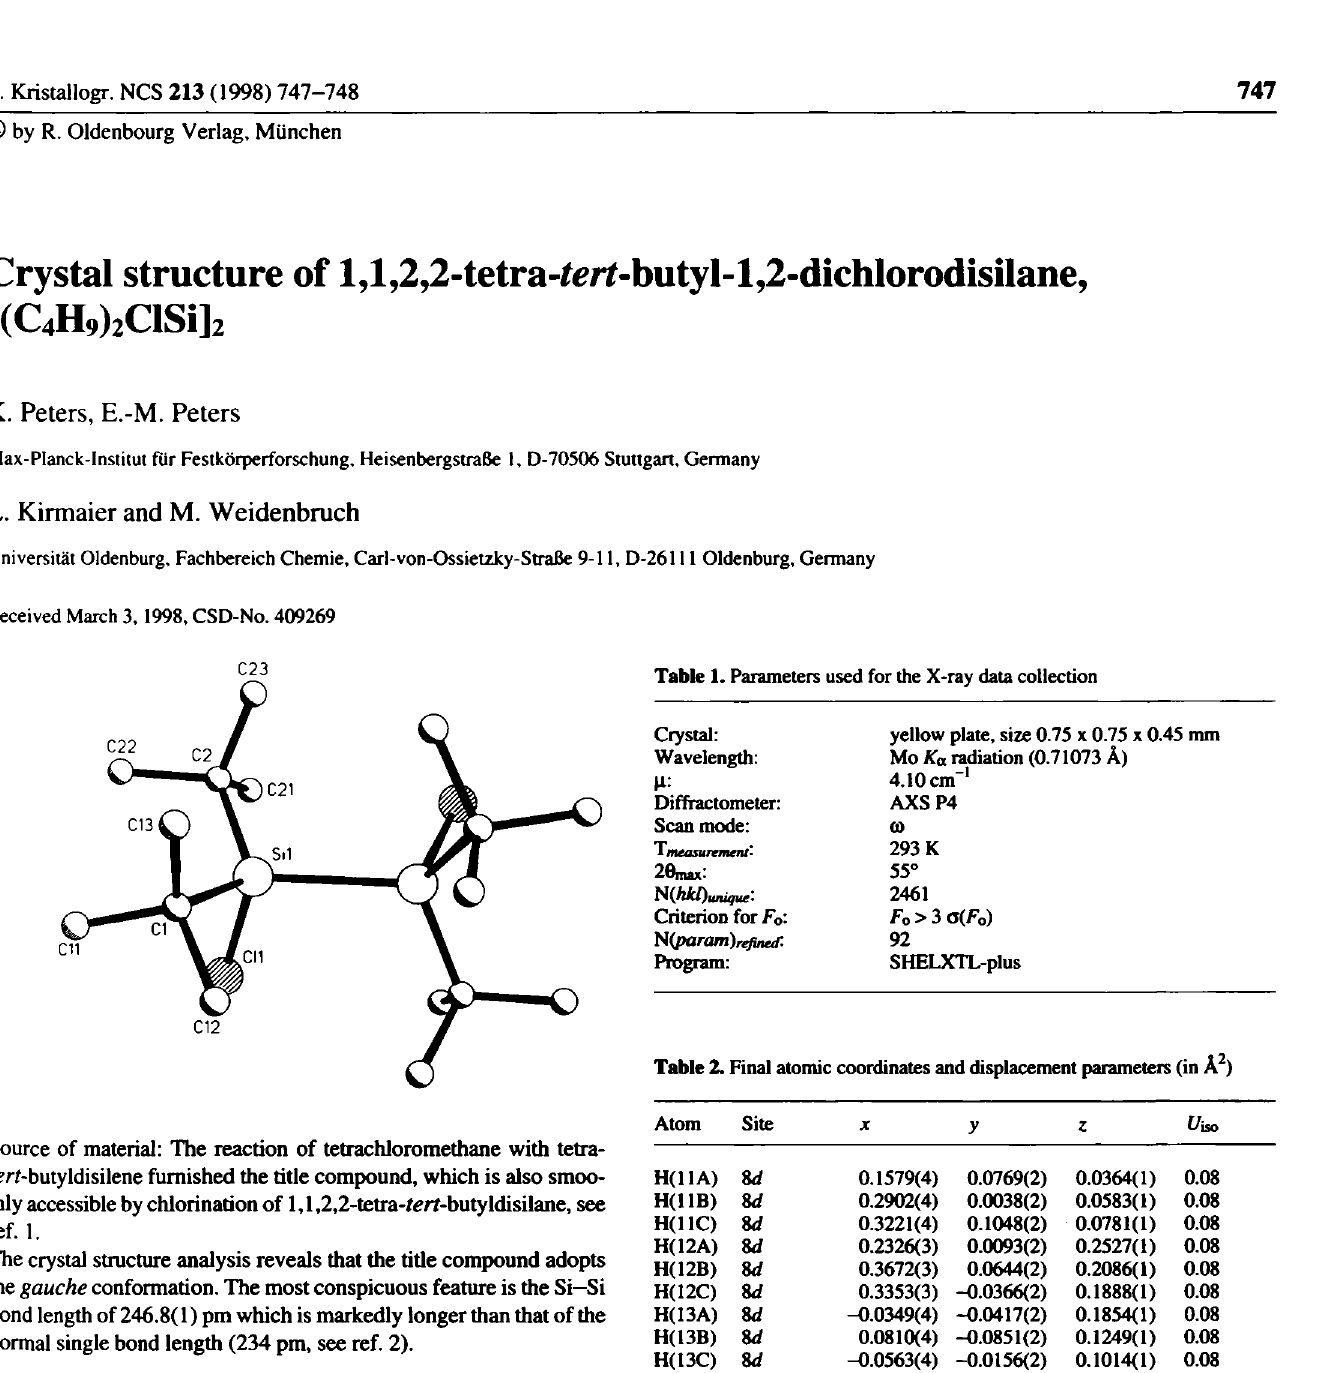
Table 3. Final atomic coordinates and displacement parameters (in